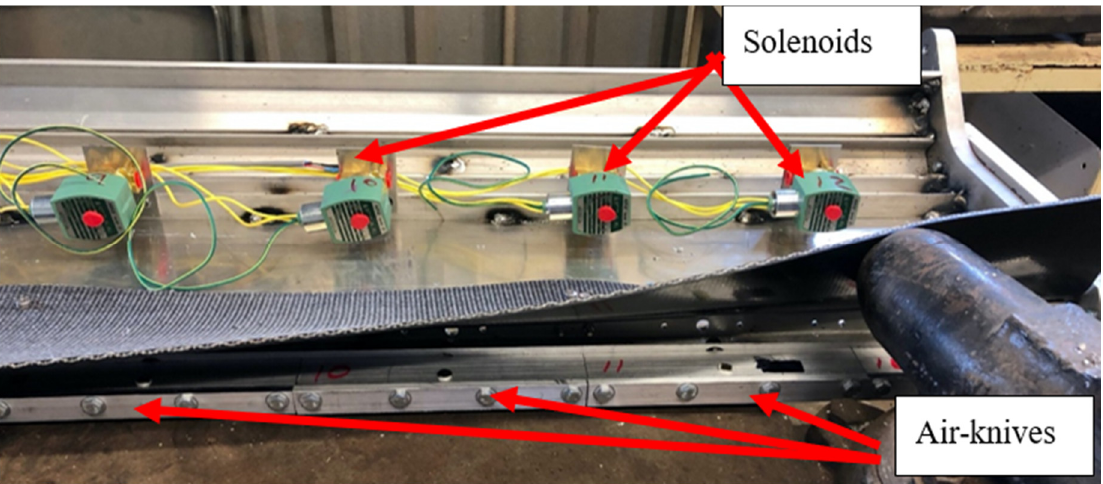
Figure 5. Under-side of the lower section of the gin-stand feeder-apron installation with a bank of 12 pneumatic solenoids that provide pneumatic actuation to 12 air-knives (two air-knives per node with each node controlling four air-knives, their two local air-knives plus one on either side of the node to allow for ejection of plastic detected along the edge between nodes).